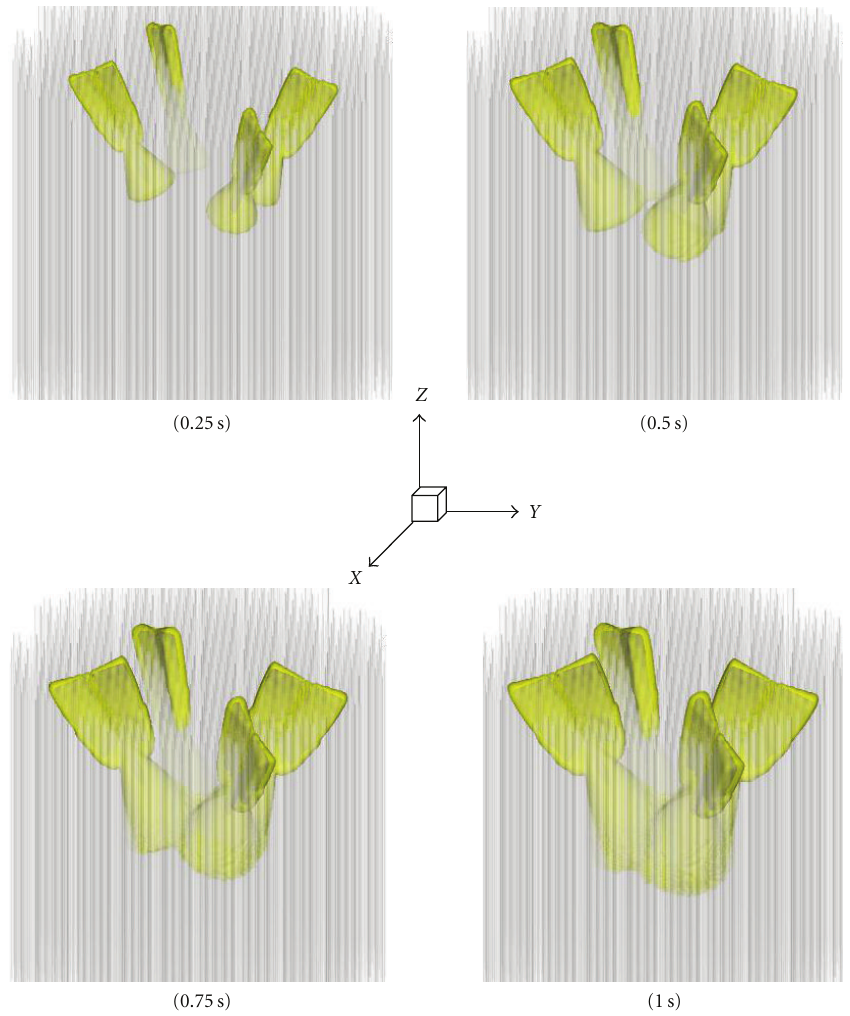
Figure 13: Iso-surface of four boron